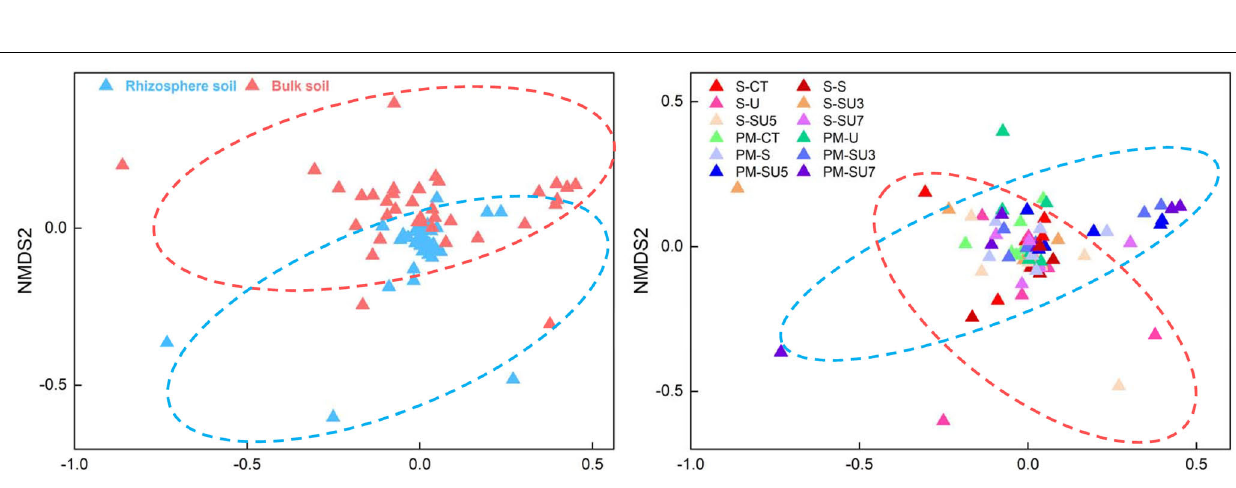
Frontiers in Microbiology |